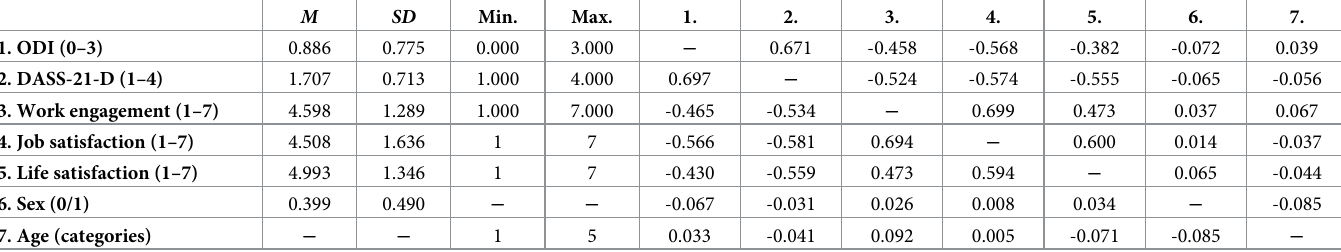
Table 3. Pearson and Spearman correlations among the main study